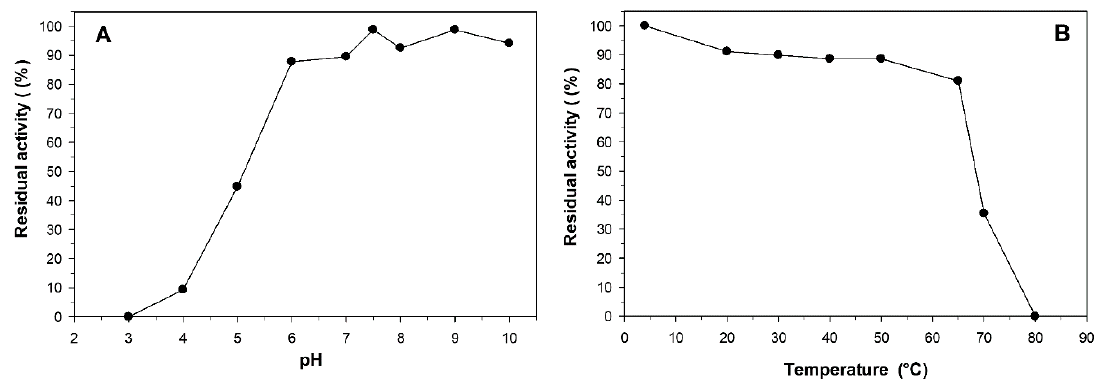
Figure 3. Stability of L -arabinose isomerase US100 from Bacillus stearothermophilus towards: ( A ) pH; ( B ) temperature. The pre-incubation time in both cases was 1 h.